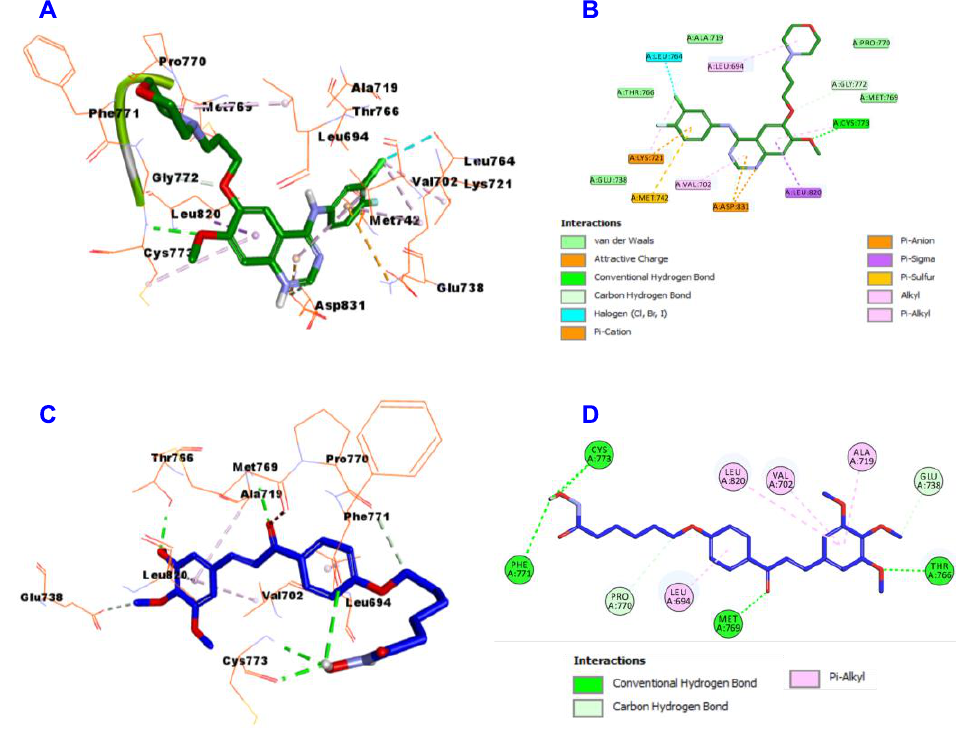
Figure 6 . Docking and binding mode of Gefitinib (green) and 4b (blue) into ATP-active site of EGFR kinase (PDB code: 1M17); ( A ) 3D structure of Gefitinib , ( B ) 2D structure of Gefitinib , ( C ) 3D structure of 4b , ( D ) 2D structure of 4b .